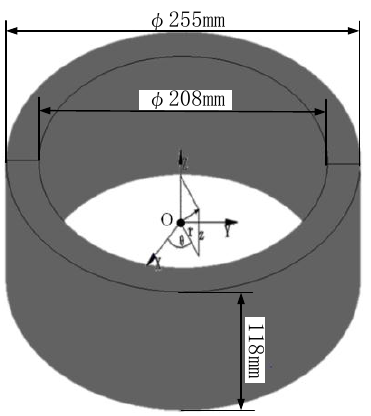
Figure 13. Blank of aero engine case.